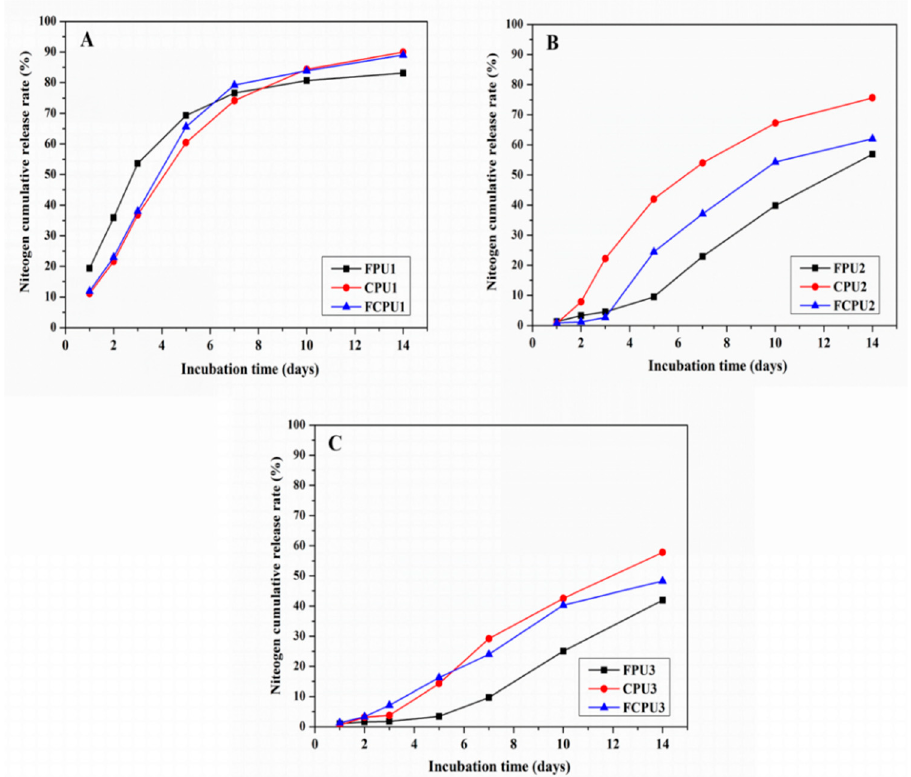
Figure 8. Cumulative nitrogen release rate of different coated fertilizers at 25 °C in water. Release curves of FPUs, CPUs and FCPUs for ( A ) 4%, ( B ) 6% and ( C ) 8% coating percentage, respectively.